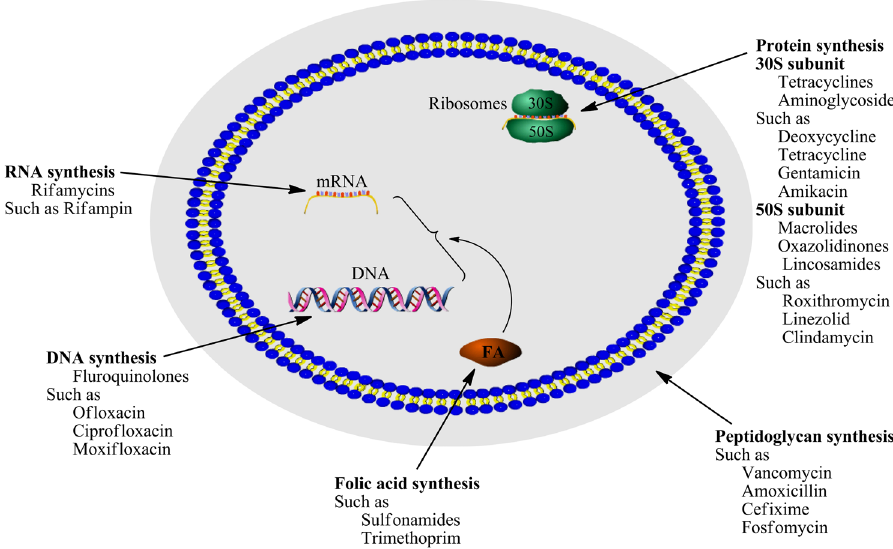
Figure 2. Main macromolecular targets involving antimicrobial mechanisms. This figure was drawn successively using Pathway Builder Tool 2.0, ChemBioOffice 2010 and Adobe Photoshop